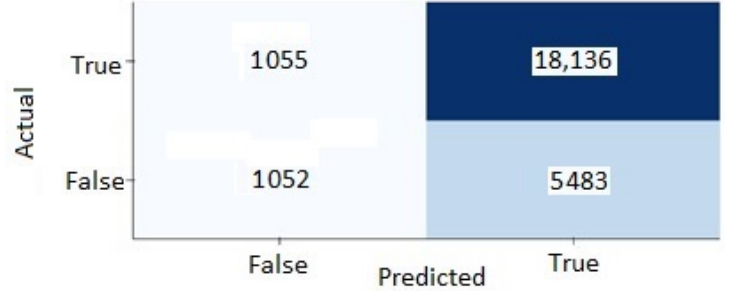
Figure 8. Confusion matrix of the fourth model.